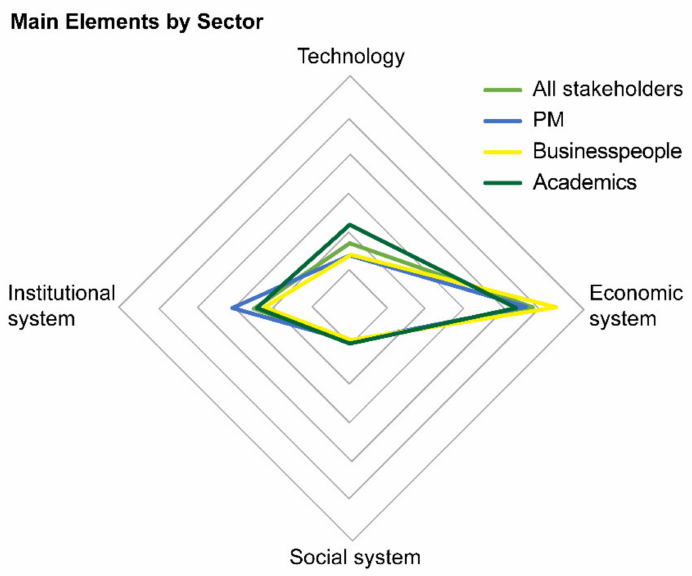
Figure 3. Consistency of the results of the evaluation of the main elements among